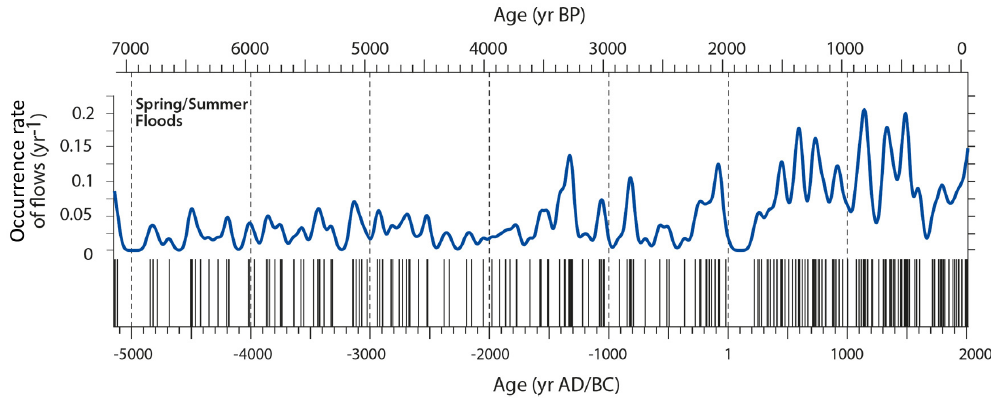
Figure 4. A 7000-year reconstruction of flood events from Mondsee, Upper Austria. Lower panel: occurrence of flood events. Upper panel: occurrence rate calculated by using a Gaussian kernel regression with a 30-year bandwidth (data from Swierczynski et al.,